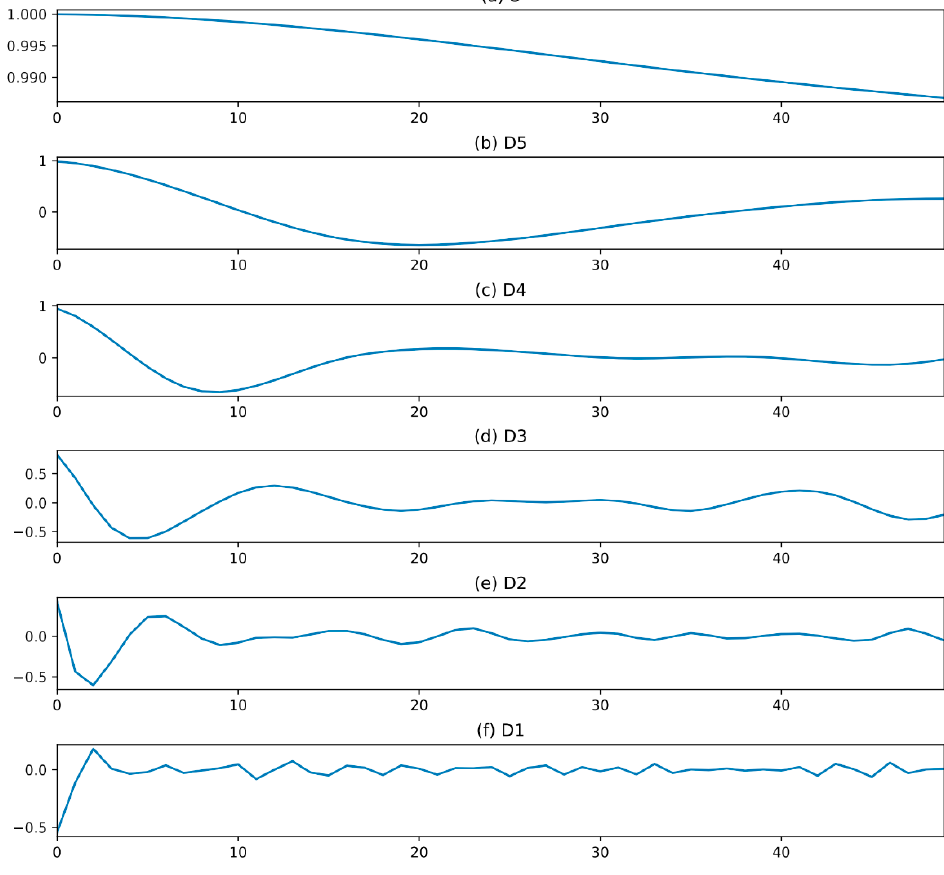
Figure 6. Autocorrelation analysis results for multi-scale coefficients.